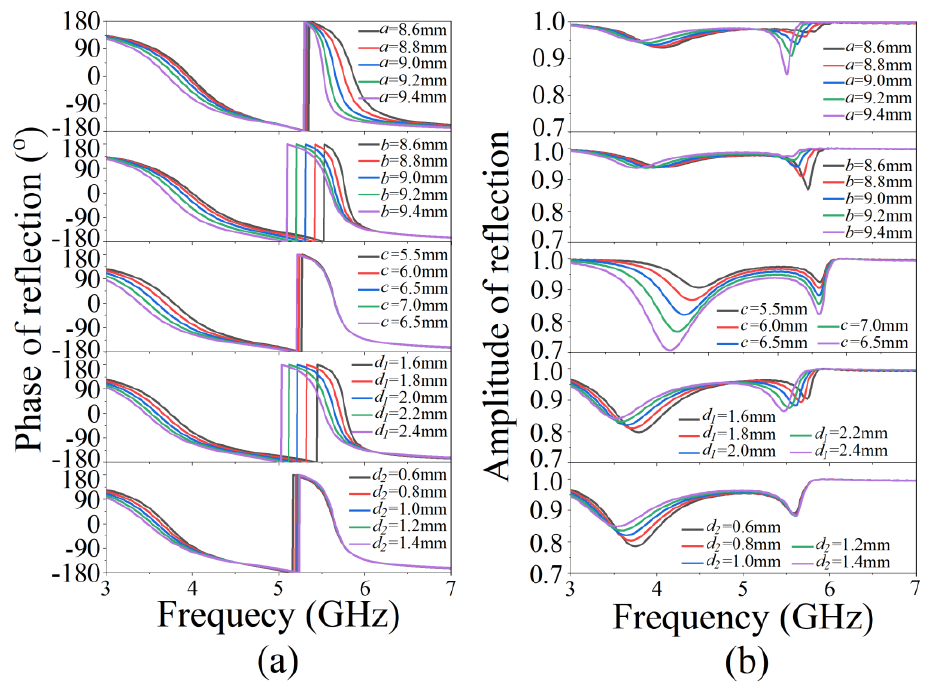
Figure 5. Simulated complex reflection coefficient with varying geometrical parameters: ( a ) phase and ( b ) amplitude for varying a , b , c , d 1 , and d 2 .